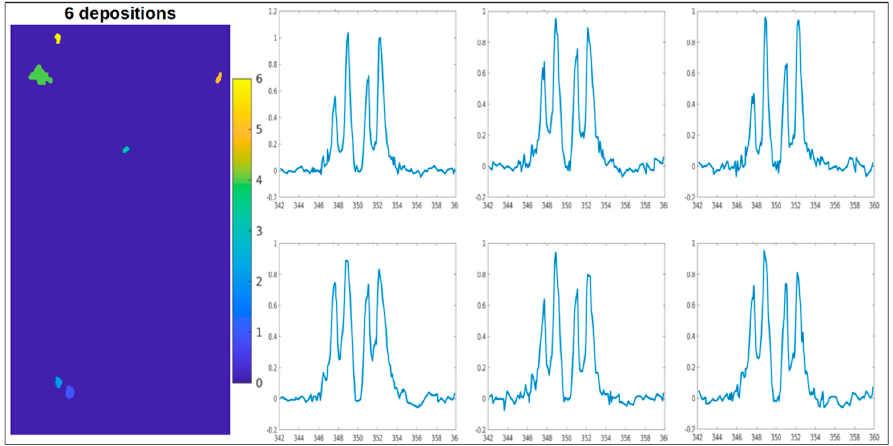
Figure 5. ( a ) Binary map with the Ca depositions of the field of view in Figure 3a–c from bMSC-4D. Colored pixels are the ones that satisfy the S/N criterion defined in the text. Six depositions were big enough to allow spectroscopic analysis, and the respective spectra are reported from panel ( b – g ) with the number of pixels of the corresponding deposition. The showed spectra have peaks structure and relative peaks intensities similar to the calcite reference standard (Figure 4b).